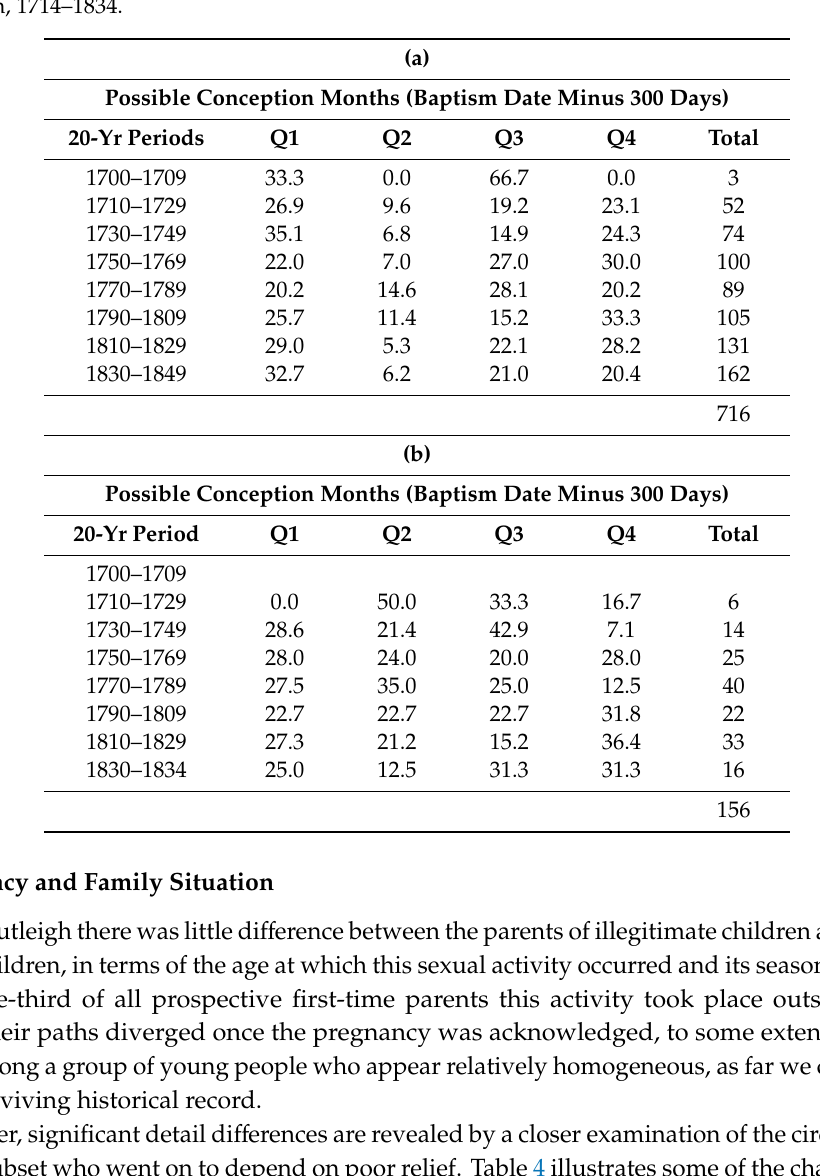
(a) Butleigh and District All First Children, 1700–1849; (b) Butleigh, Illegitimate Children,